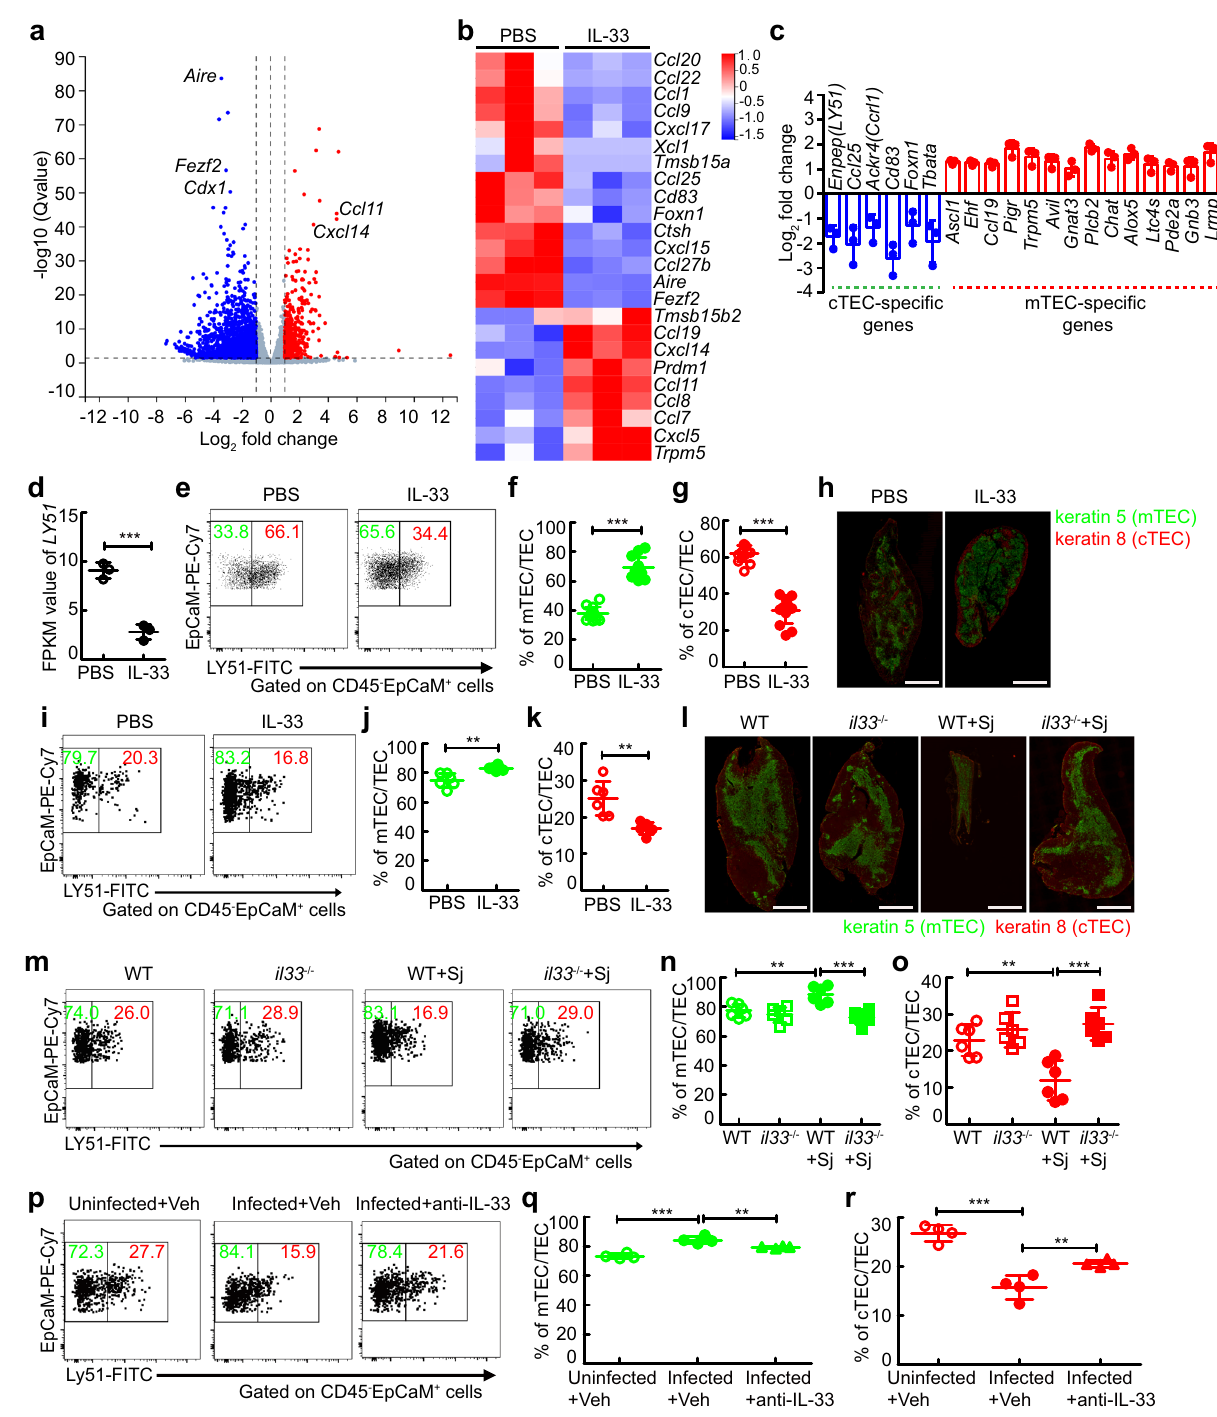
Fig. 5 | IL-33 perturbs the function and compartment of thymic epithelial cells. a – d TECs from thymus cultured in FTOC treated with IL-33 ( n =3 biologically independent samples of fetal thymic lobes) to perform RNA-seq analysis. a Volcano plot shows genes differentially expressed in TECs. b Heat map shows TEC function- associated genes. c cTEC or mTEC-speci fi c genes. d FPKM value of Enpep gene (encoding LY51) of TECs ( n =3 biologically independent samples of fetal thymic lobes), P =0.0006. e – g Representative and quanti fi ed fl ow cytometry of mTECs and cTECs from thymus cultured in FTOC treated with IL-33 ( n =13 biologically independent samplesoffetalthymiclobes,poolofthreeindependentexperiments), P <0.0001(mTECorcTEC). h HistologyofthethymusfrommicetreatedwithIL-33orPBS;Green, Keratin5;Red,Keratin8;Scalebar,1000 μ m. i – k Representativeandquanti fi ed fl owcytometryofcTECsormTECsinthethymusfrommicetreatedwithIL-33( n =6mice, pool of two independent experiments), P =0.0025 (mTEC), P =0.0025(cTEC). l Histology ofthe thymus from WT or il33 − / − mice 8 weeks after infection; Green, Keratin5; red, Keratin 8; Scale bar, 1000 μ m. m – o Representative and quanti fi ed fl ow cytometry of cTECs or mTECs in the thymus from WT or il33 − / − mice 8 weeks after infection ( n =6 mice, pool of two independent experiments). WT+Sj versus WT, P =0.0057 (mTEC), P =0.0038 (cTEC); WT+Sj versus il33 − / − +Sj, P =0.0002 (mTEC), P =0.0001 (cTEC). p – r Representative and quanti fi ed fl owcytometryof cTECs ormTECs in the thymusfrom schistosome-infectedmicetreated with anti-IL-33( n =4 mice).Infected +VehversusUninfected+Veh, P <0.0001(mTEC), P <0.0001(cTEC);Infected+VehversusInfected+anti-IL-33, P =0.0099(mTEC), P =0.0099(cTEC).Alldataareshownas the mean ± s.d. * P <0.05, ** P <0.01, *** P <0.001, NS, not signi fi cant. d , f , g , j , k Unpaired two-tailed Student ’ s t -test; n , o , q , r One-way ANOVA with Tukey ’ s multiple comparisons. Source data a r e provided as a Source Data fi